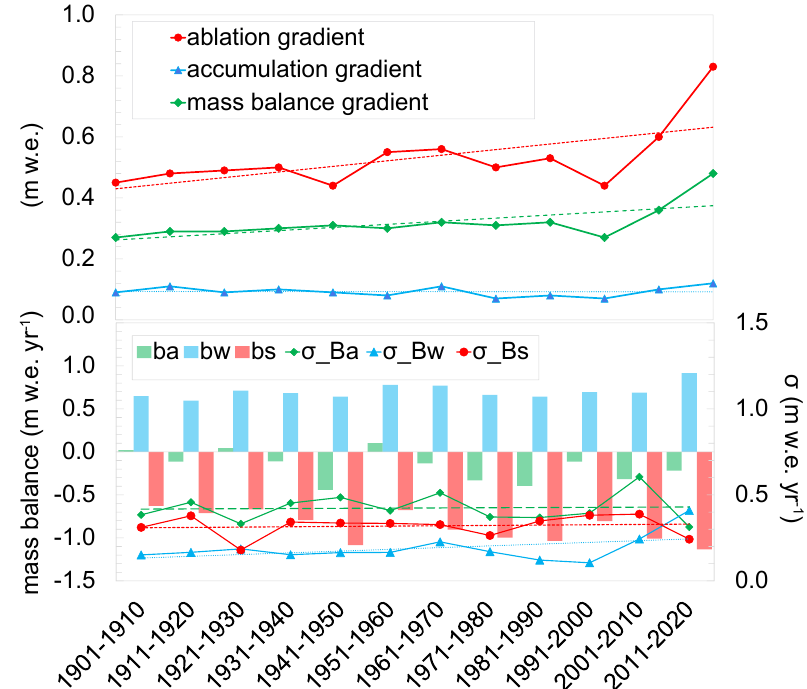
Figure 7. Top : Ablation, accumulation, and mass balance gradient averaged for 10-year periods. Bottom : 10-year average summer, winter, and annual mass balance (bars) and year-to-year variability of summer, winter, and annual mass balance for 10-year periods ( σ : symbols).